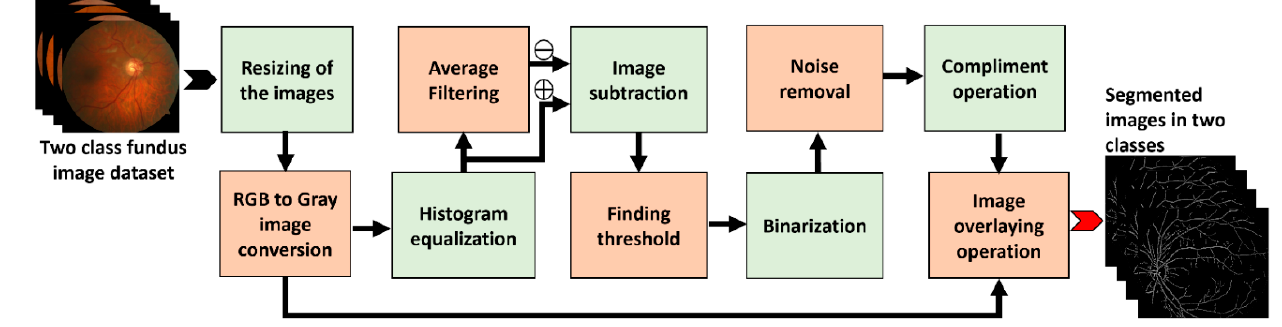
Figure 4. Overview of the proposed DR classifier.